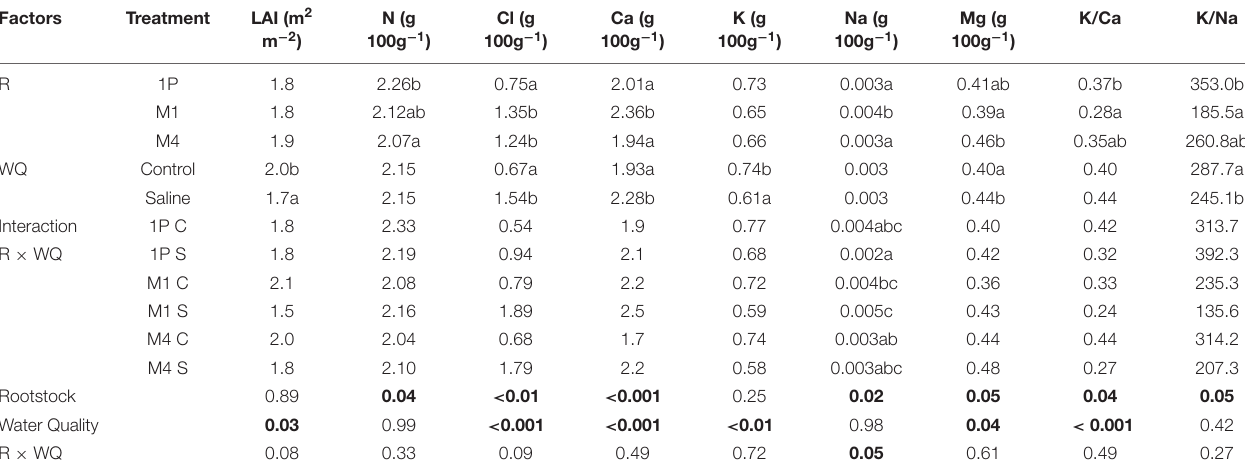
TABLE 2 | Leaf area index (LAI) and leaf nutritional status in leaf blades from Vitis vinifera (L.) cv. Tempranillo grafted onto M1, M4 and 1103-Paulsen (1P) rootstocks subjected to different water quality (C; control and S; saline irrigation) on DOY 233 of 2019 in Valencia, Spain. Factors Treatment